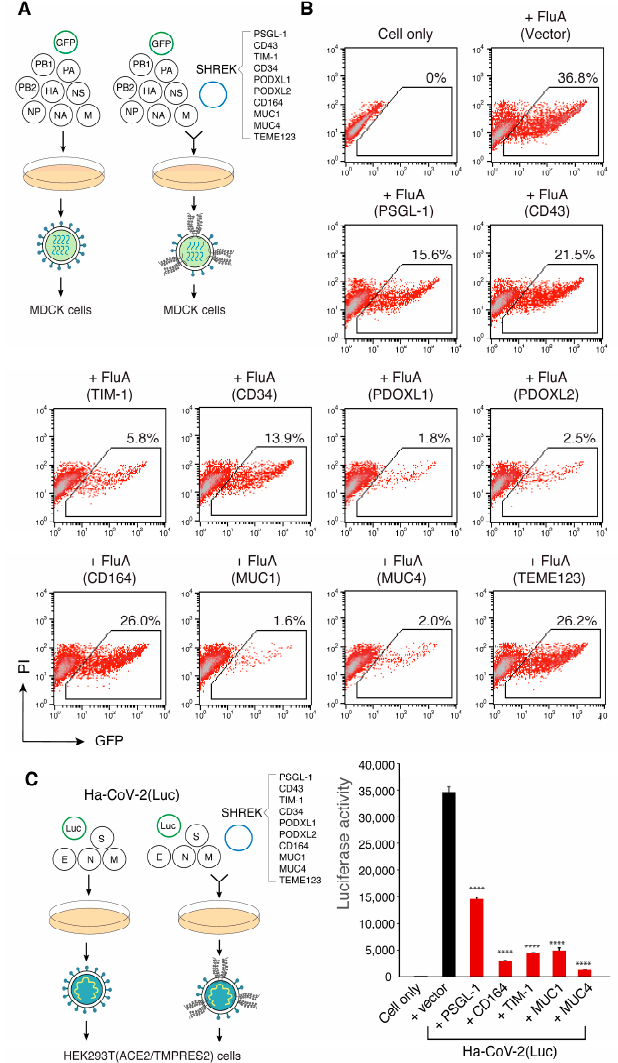
Figure 6. SHREK proteins are broad-spectrum host antiviral factors. ( A ) SHREK proteins inactivate influenza A virion infectivity. Influenza A-GFP reporter viruses were assembled by cotransfection of HEK293T cells with eight vectors expressing each of the segments of influenza A/WSN/33 (H1N1) (0.25 µg each), pHW-NA-GFP ( Δ AT6) (1.5 µg), and each individual SHREK-expressing vector or an empty vector (0.5 µg). Viral particles were harvested at 48 h and used to infect target MDCK cells. This experiment was repeated 3 times. ( B ) Representative results from ( A ), showing GFP+ cells being quantified by flow cytometry following infection for 24 h. ( C ) SHREK proteins inhibit Ha-CoV-2 infection. Ha-CoV-2(Luc) particles were assembled in HEK293T cells by cotransfection of SARS-CoV-2 S-, M-, N- and E- expressing vectors (0.3 µ g each), Ha-CoV-2(Luc) vector (1.2 µ g), and each individual SHREK-expressing vector or an empty vector (1.6 µ g). Virions were harvested, and used to infect HEK293T(ACE2/TMPRSS2) target cells. Luciferase activity was quantified at 18 h post infection. The experiment was repeated four times. Data are presented as means ± SD from experiment triplicate. p -values were calculated using the two-tailed T-test. Significance values are indicated using asterisks as follows; **** = p <